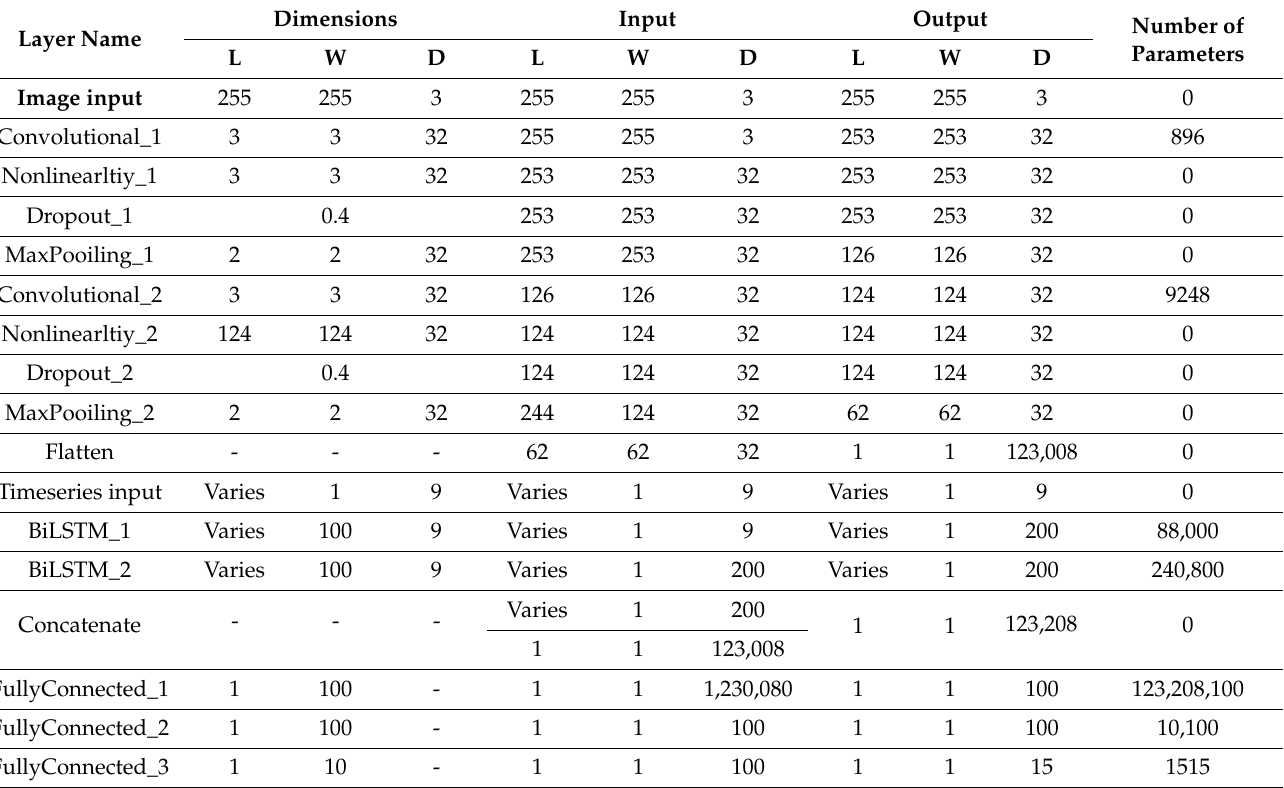
Table 2. Dimensions and parameters of the proposed